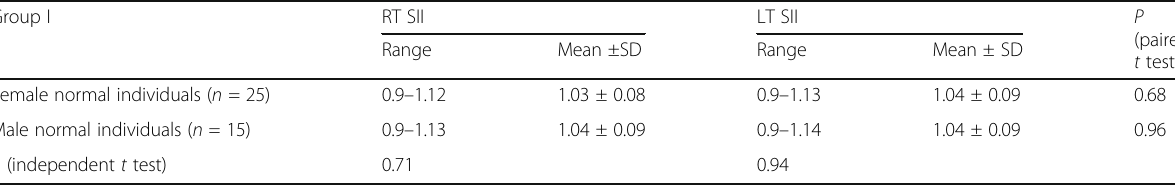
(paired t test )Range Mean ±SD Range Mean ± SD